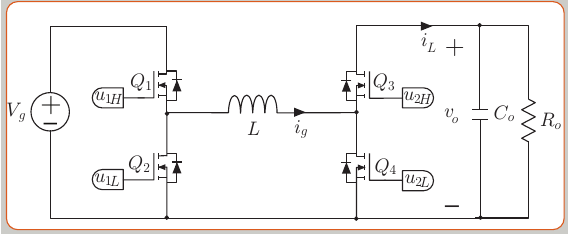
Figure 2. Topology of the noninverting buck–boost converter. Table 1. Peak-to-peak ripple amplitudes for BB and